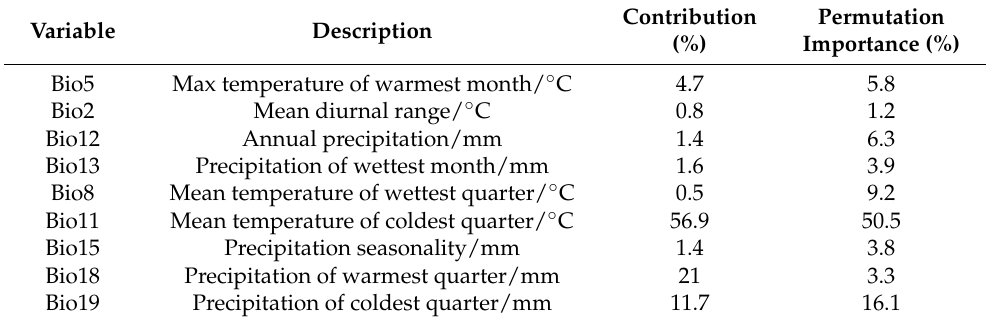
Table 1. Contribution percentage of each environmental faction MaxEnt